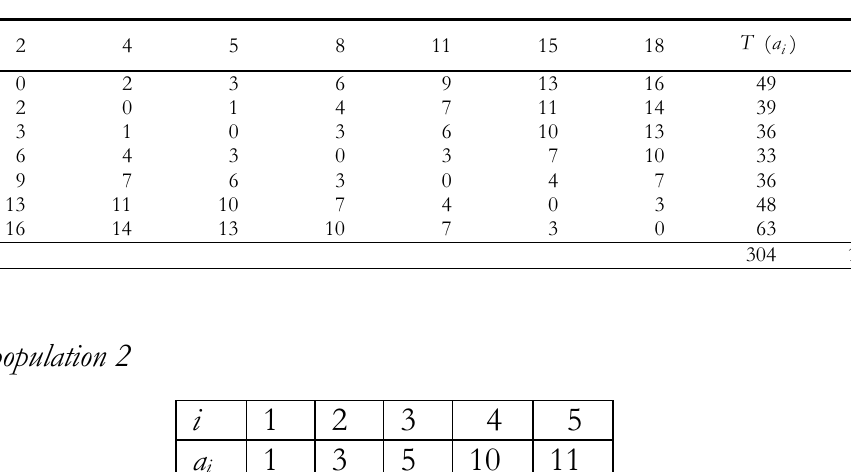
- a | , (cid:39) and (cid:30) for the data of population j i